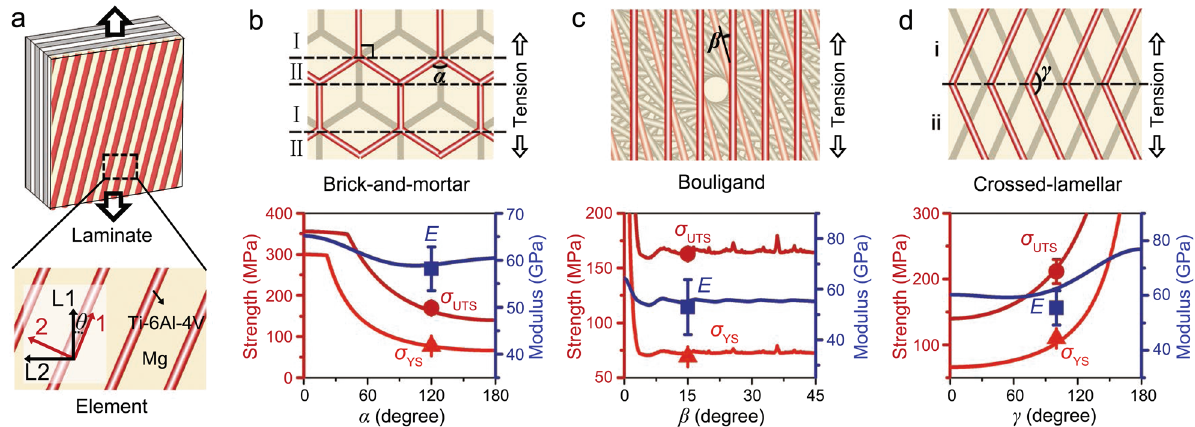
Fig. 4 Laminate theory analysis for the Young ’ s modulus and strengths for the three types of bioinspired architectures. a Schematic illustration of the elementary structural unit extracted from an individual lamina in the laminate subject to in-plane uniaxial tension. The local coordinate system for the element and the global coordinate system for the lamina are denoted, respectively, using (1, 2) and (L1, L2). b – d Schematic illustrations of the spatial arrangements of constituents for the bioinspired ( b ) brick-and-mortar, ( c ) Bouligand, and ( d ) crossed-lamellar architectures, and the theoretical results on the variations in the Young ’ s modulus E , yield strength σ YS and ultimate tensile strength σ UTS of the composites as a function of the speci fi c angles α , β and γ . The experimental data (solid dots) are also presented for